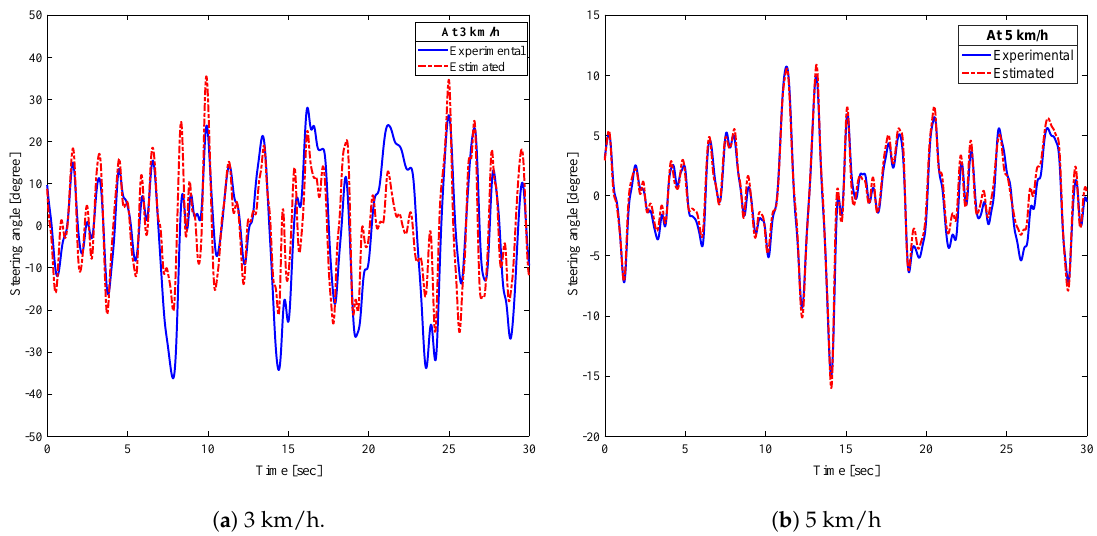
Figure 13. Validation of estimated steering angle from the experimental